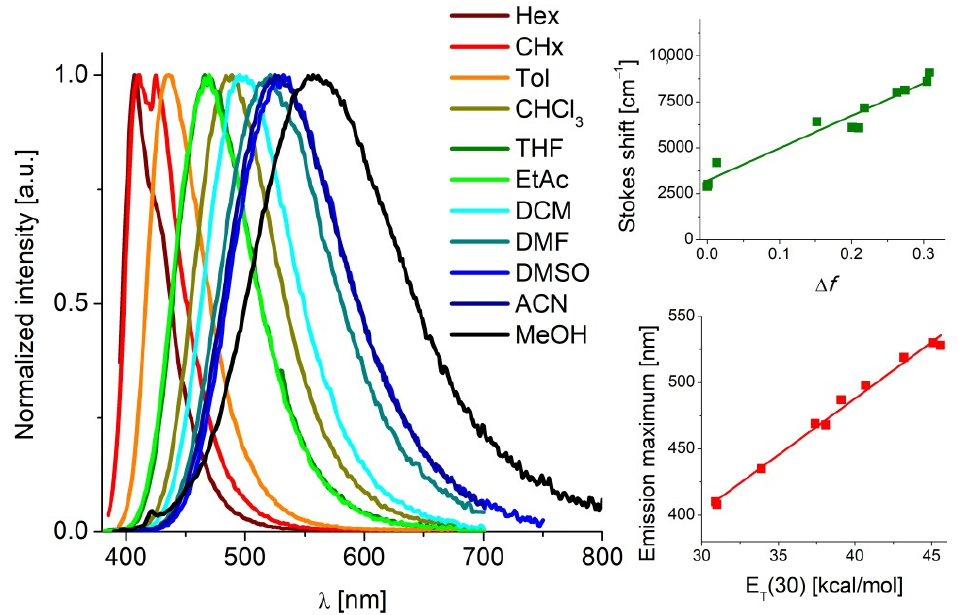
Figure 3. PL spectra of tBuTPAterpy in various solvents at room temperature (c = 10 µ M). Insets: Lippert—Mattaga plot of tBuTPAterpy at room temperature (top); emission maximum vs Dimroth– Reichardt polarity parameter E T (30) for the employed solvents (bottom). Table 1. Spectral properties of tBuTPAterpy.